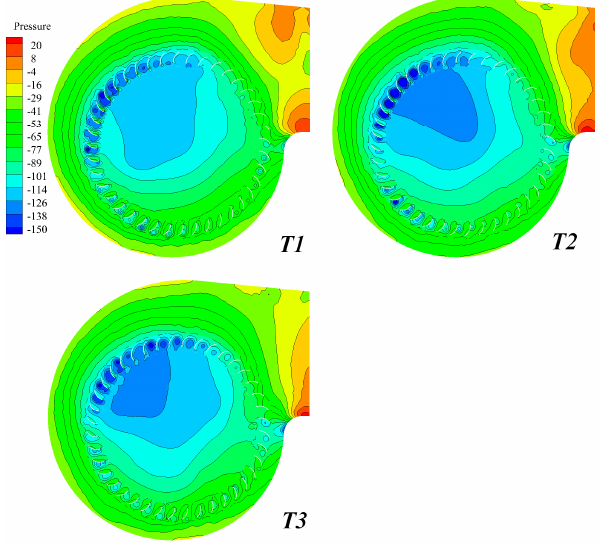
Figure 17. Static pressure at different times of Z = 0.015 m section (Q/Qn = 0.031).